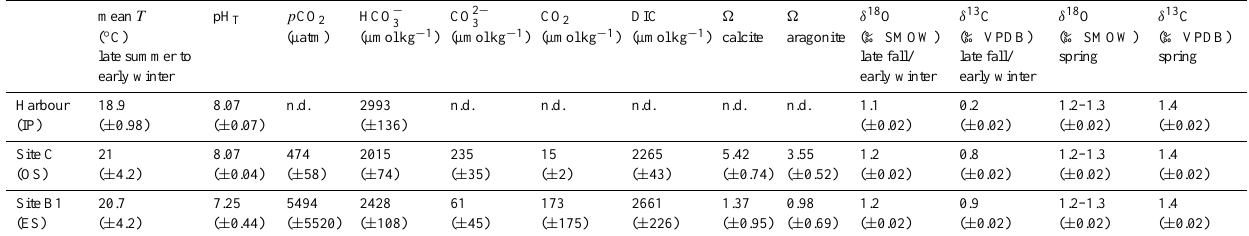
Table 1. Parameters of harbour and field experimental sites. Mean ± S.D. seawater chemistry calculated over the experiment period at the experimental site B1 and control site C. pH T is in total scale; p CO 2 in µatm; HCO − in µmolkg − 1 ; saturation state ( (cid:127)) of aragonite and calcite. IP=Ischia port (harbour); OS=ocean seawater off Ischia; ES=experimental